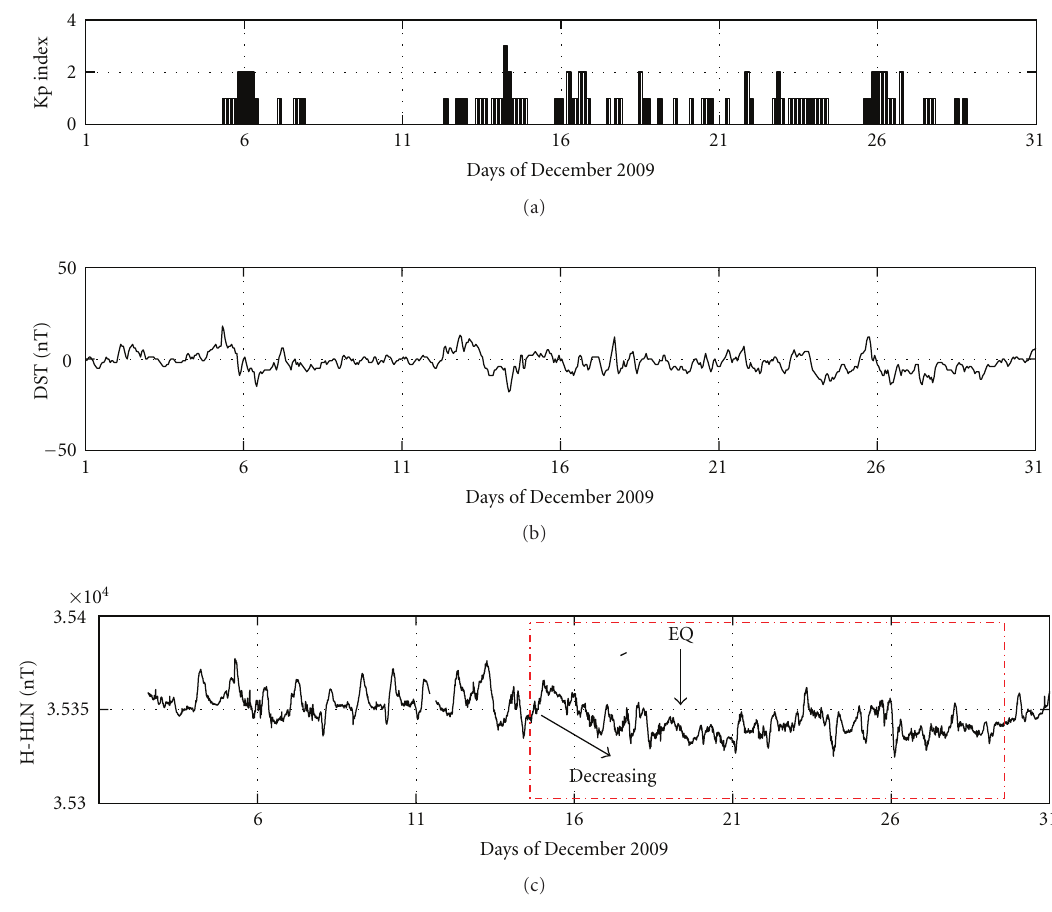
Figure 2: The comparison of the H-component recorded at the HLN station with the Dst and Kp index data from World Data Center (WDC) for Geomagnetism, Kyoto. The rectangle indicates to the abnormal variation of crustal origin in the H-component. It has been revealed from the DST and Kp index that there is no significant external field variation during the occurrence time of the